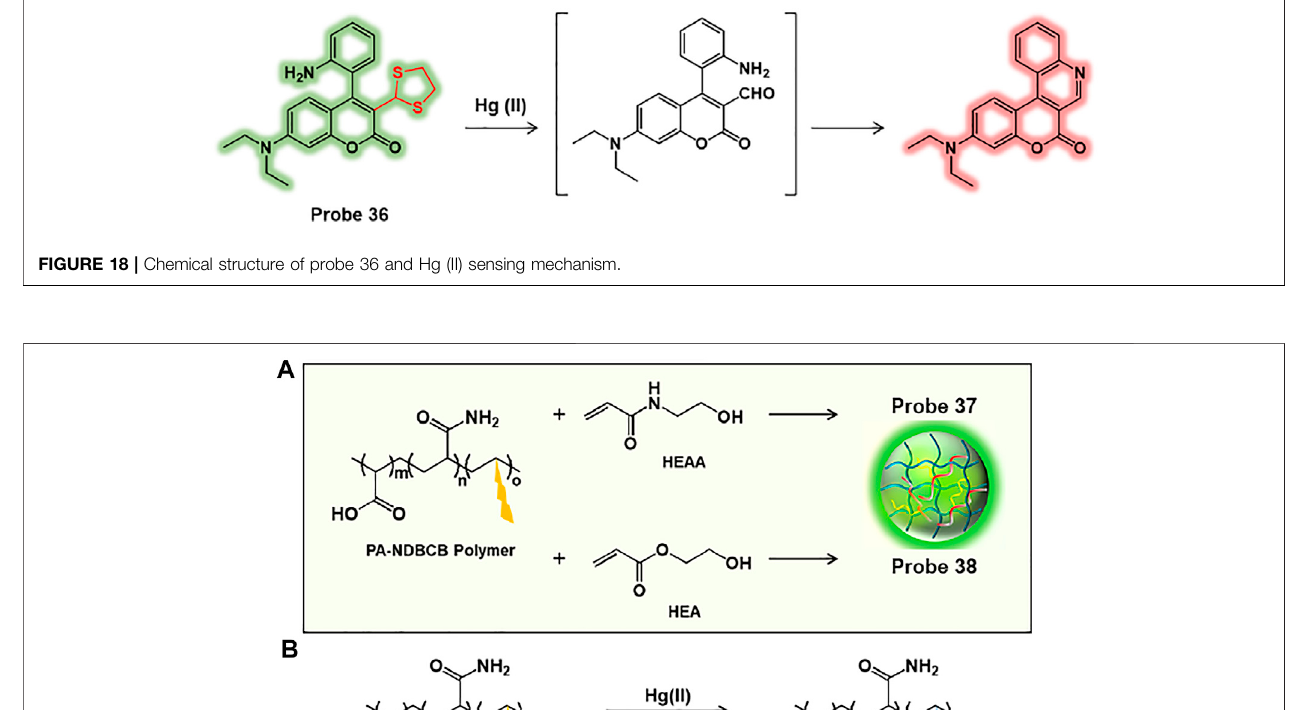
– 48 h E. coli coculture. Reproduced 425 /I 510 of probes 37 and 38 for 0